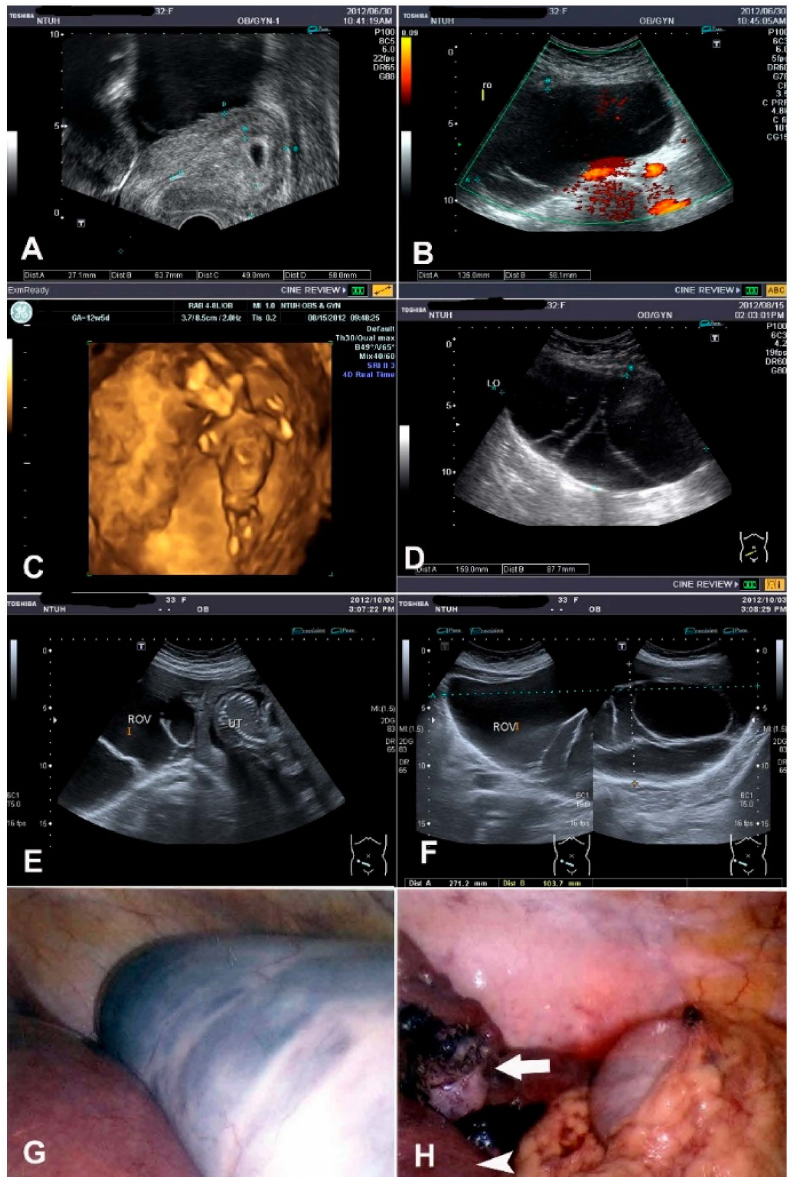
Figure 4. Mucinous tumor. ( A ) Ultrasonography revealing GA 5 weeks with an intrauterine gesta- tional sac. ( B ) Ultrasonography revealing a right multilocular ovarian cyst sized 13.5 cm. ( C ) Three- dimensional ultrasonography at GA 12 weeks revealing early pregnancy with normal fetal growth. ( D ) Follow-up ultrasonography revealing a rapidly enlarging cyst (16 cm) at GA 12 weeks. ( E ) Ultra- sonography revealing a right ovarian multilocular cyst and normal intrauterine pregnancy. ( F ) Ultra- sonography revealing a rapidly enlarging cyst (27 cm) at GA 21 weeks. ( G ) Laparoscopic right partial oophorectomy after aspiration of 3000 mL of mucinous fluid content. ( H ) White arrow indicates the residual right ovary, which was difficult to remove totally because of the large gravid uterus (white arrow